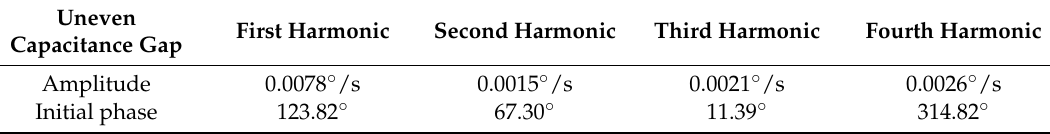
Table 1. Harmonic analysis results of the HRG output for 1.3 µ m–270 ◦ uneven capacitance gap(1 ◦